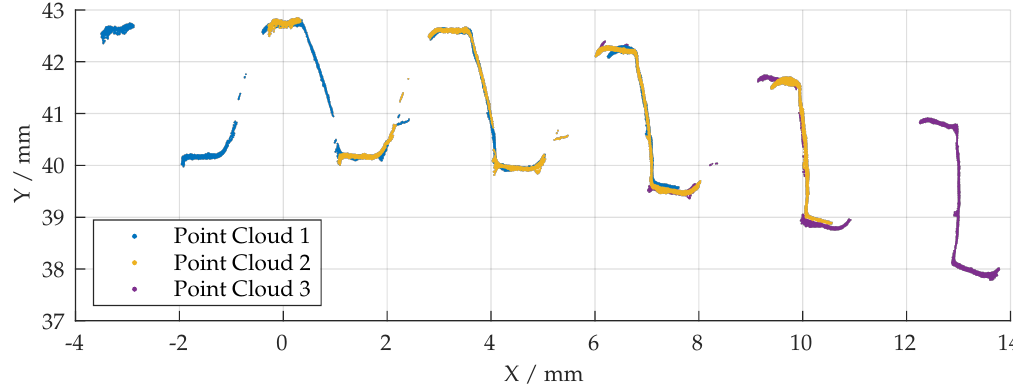
Figure 17. Result of registration approach for the first three point clouds.